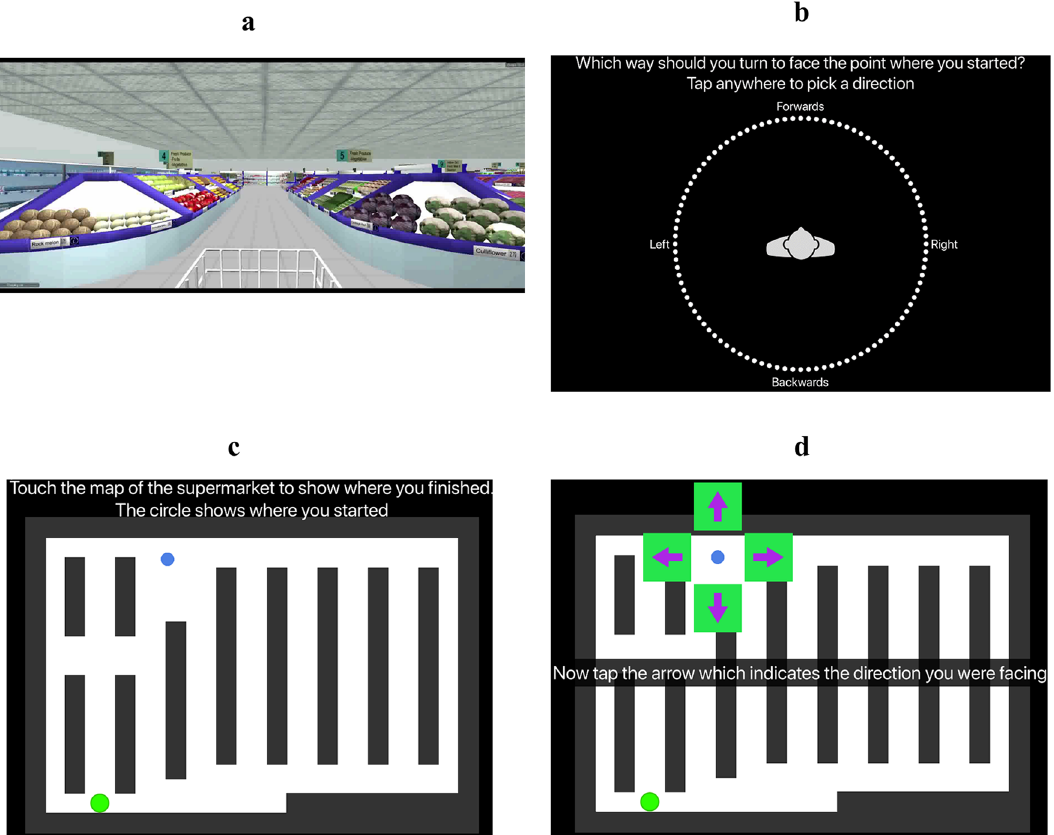
Figure 1. Illustration of the VST. ( a) Participants are shown videos of a shopping trolley, from a first person perspective, moving along fixed routes in a supermarket, ( b ) Egocentric orientation component of task, where the direction of the starting location in relation to destination location must be indicated, ( c ) Allocentric orientation component of task, where the destination location must be indicated (blue circle represents example response) on a blank map of the supermarket with only the starting location labelled (green circle), ( d ) Heading direction component of task, where the direction faced when the trial finished must be indicated. Adapted from 59